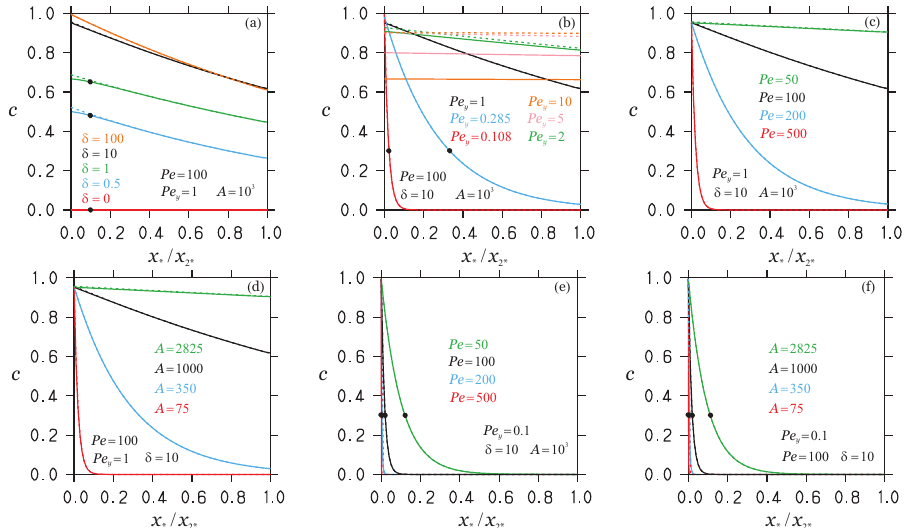
Figure 7. The concentration distribution ( a – f ) along x ∗ at y ∗ = y 2 ∗ (solid lines) by following the notation applied in Figure 6. The dashed lines show the results of model Equation